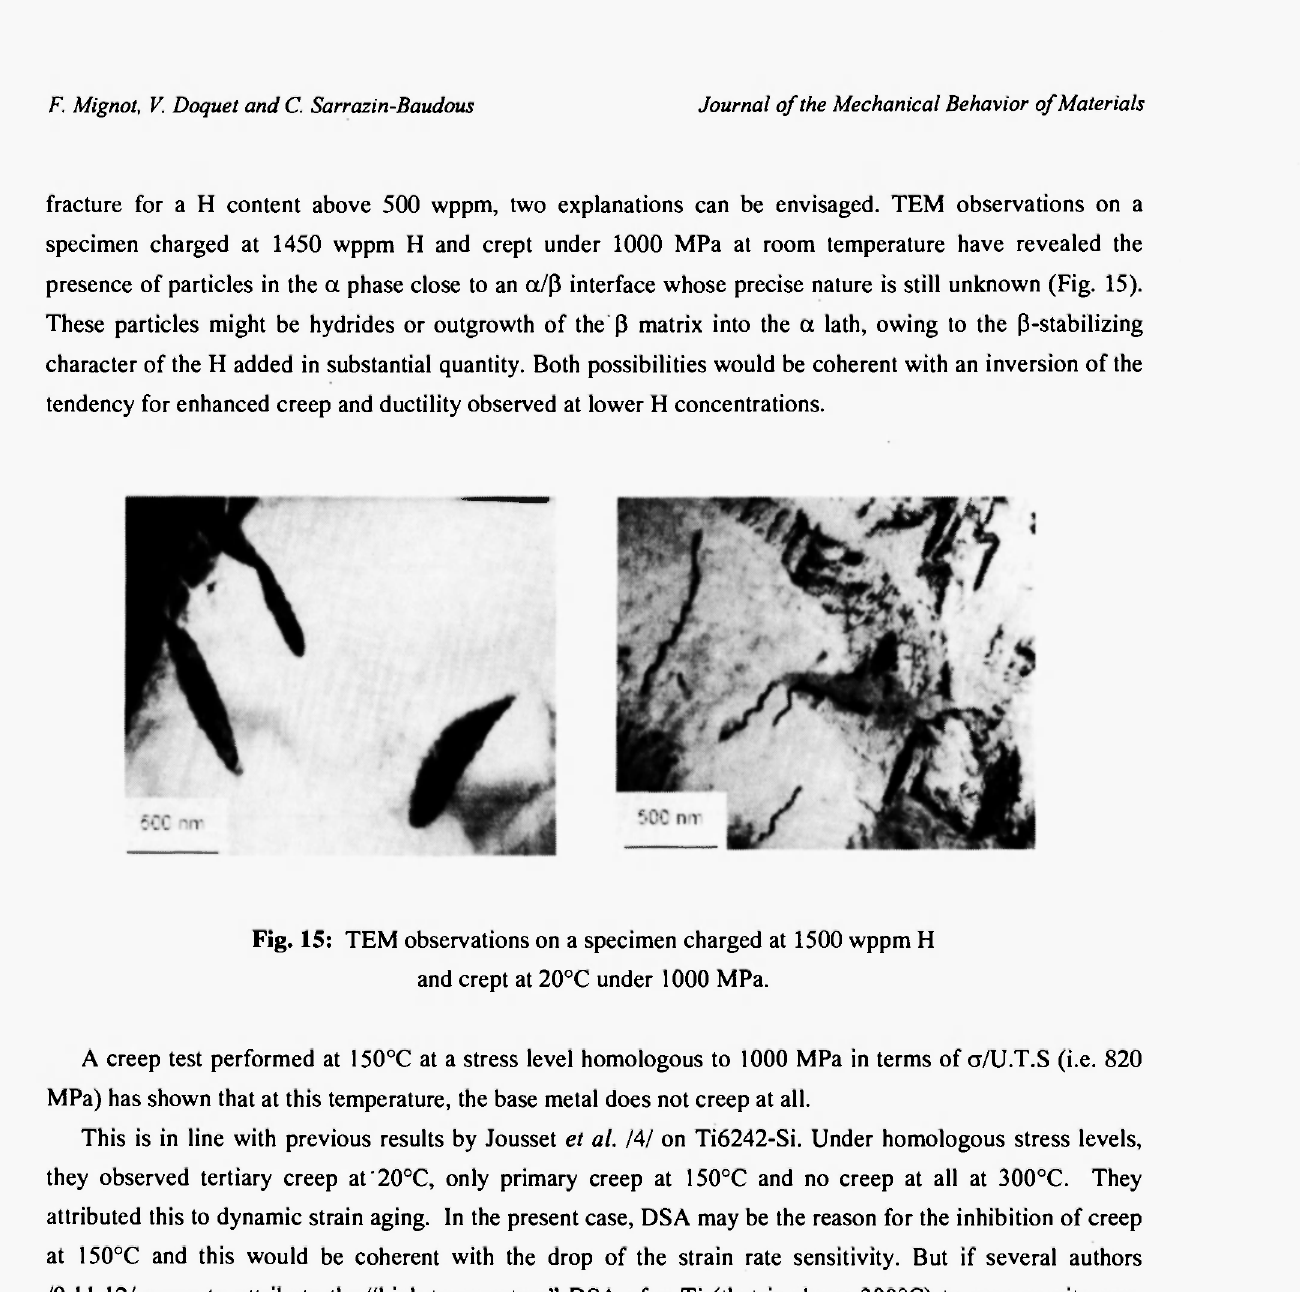
Fig. 15: TEM observations on a specimen charged at 1500 wppm Η and crept at 20°C under 1000